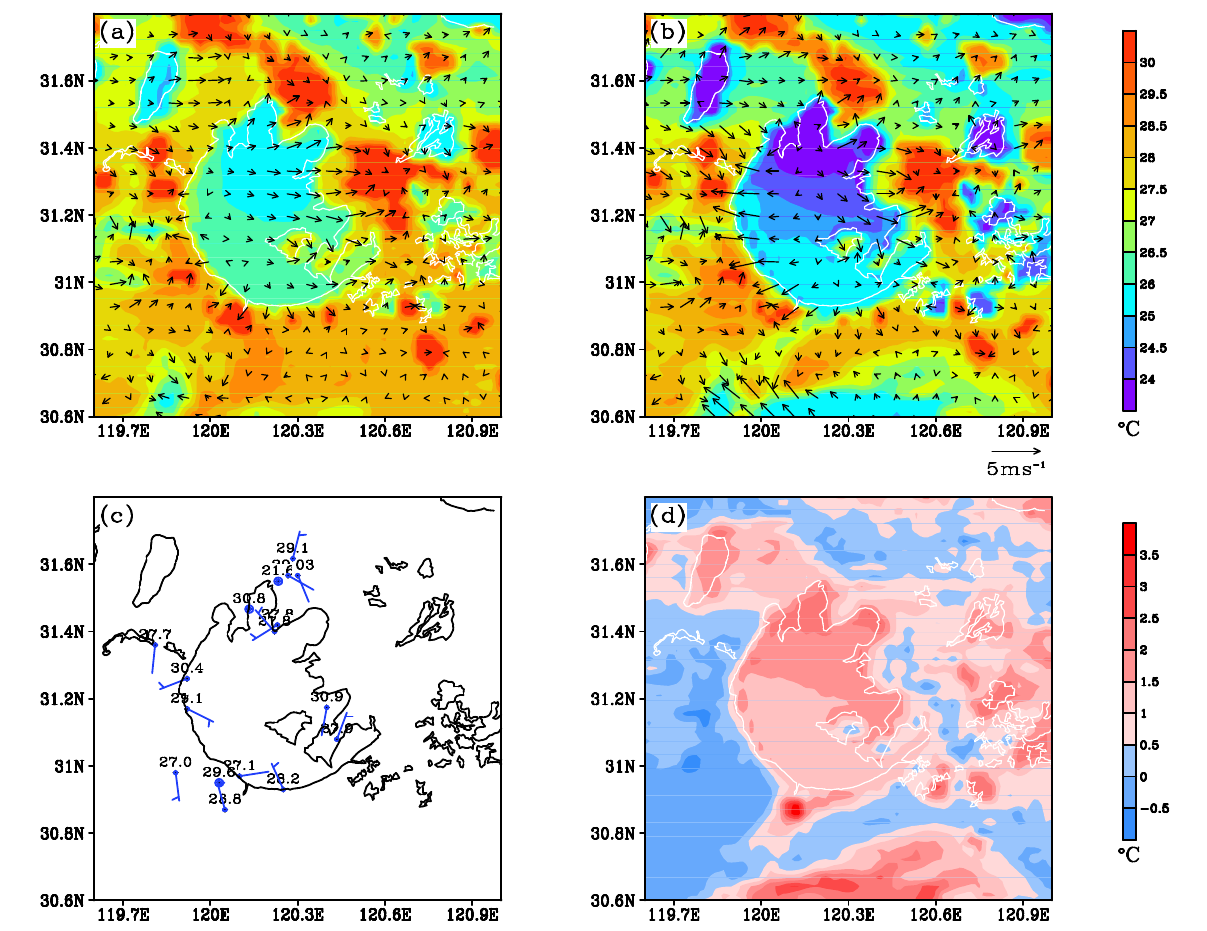
Figure 6. Modeled wind vector and air temperature at 2 m at 09:00 19 July 2012 ( a ) of S-Lake; ( b ) of D-Lake; ( c ) observed by meteorology station. ( c ) Observation by sites: the long pole is 4 m s −1 , and the short pole is 2 m s −1 ; ( d ) difference between S-Lake and D-Lake.